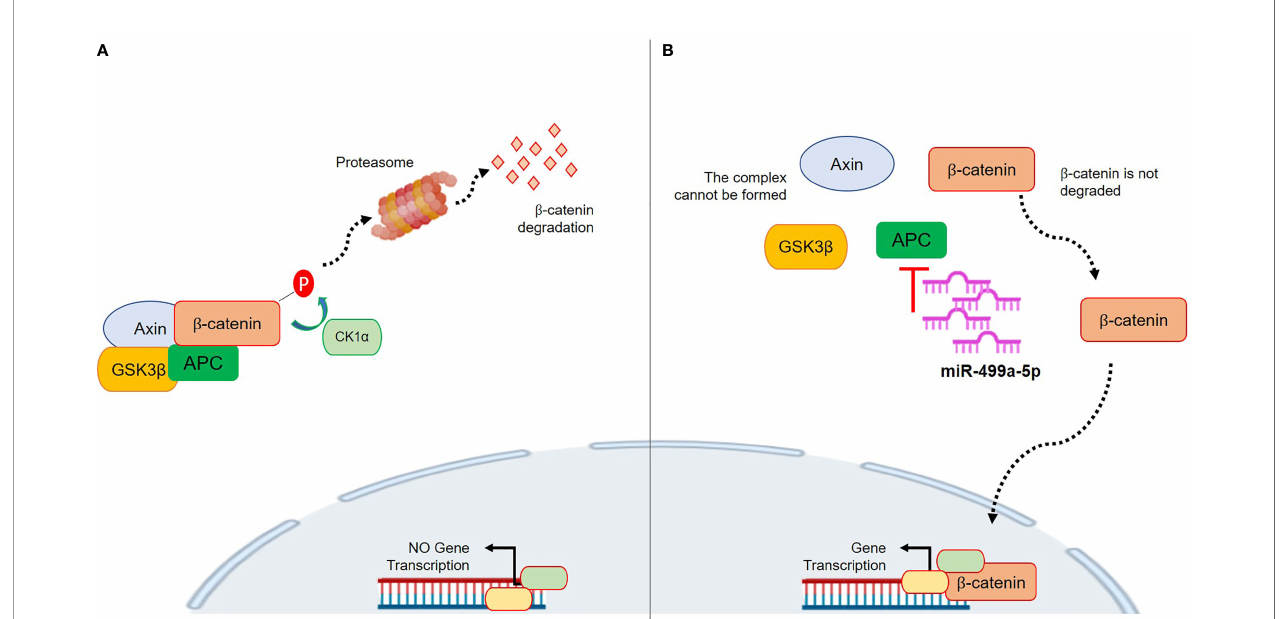
FIGURE 6 | Proposed mechanism of action of miR-499a-5p within the Wnt/ b -catenin pathway. (A) The complex formed by AXIN, CK1 a , GSK3 b , and APC phosphorylates b -catenin, which subsequently undergoes the ubiquitin-proteasomal degradation. This prevents its nuclear translocation and pro-tumor gene transcription. (B) miR-499a-5p targets APC. High expression of miR-499a-5p promotes APC inhibition, thus preventing the AXIN/CK1 a /GSK3 b /APC complex formation. Without complex, b -catenin is not degraded, and it can translocate in the nucleus where it promotes gene